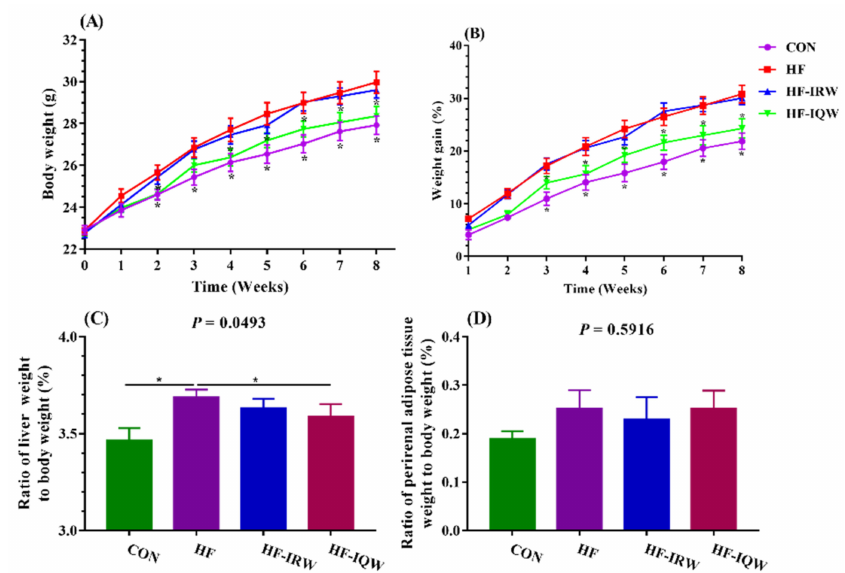
Figure 1. Egg protein transferrin-derived peptides IRW (lle-Arg-Trp) and IQW (lle-Gln-Trp) slowed weight gain, and IQW decreased the liver index of mice fed an HF (high-fat) diet. ( A ) Body weight of mice from week 0 to week 8; ( B ) body gain of mice from week 1 to week 8; ( C ) liver index of the mice; ( D ) perirenal adipose index of the mice. CON: the mice were fed the control diet; HF: the mice were fed an HF diet; HF-IRW: the mice were fed an HF diet and drank water supplemented with 0.03 g/L IRW starting from the fifth week; HF-IQW: the mice were fed an HF diet and drank water supplemented with 0.03 g/L IQW starting from the fifth week. * indicates p < 0.05 between the HF group and other